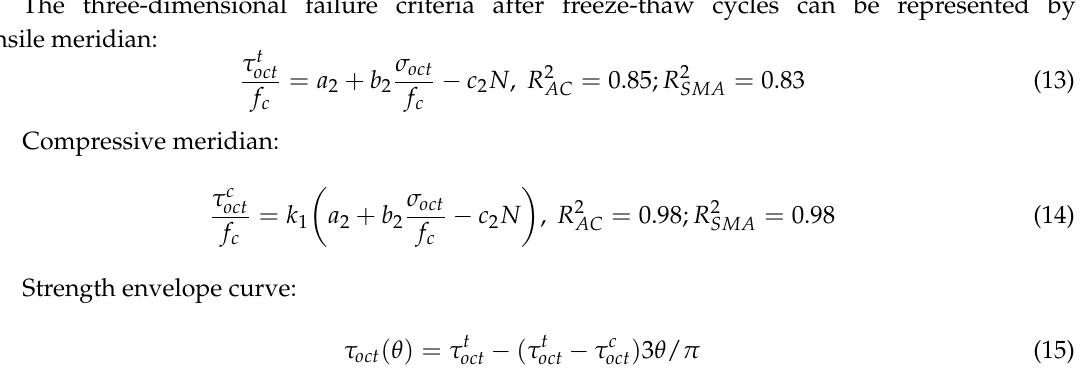
Table 7. Failure strength of asphalt mixtures after freeze-thaw cycles.